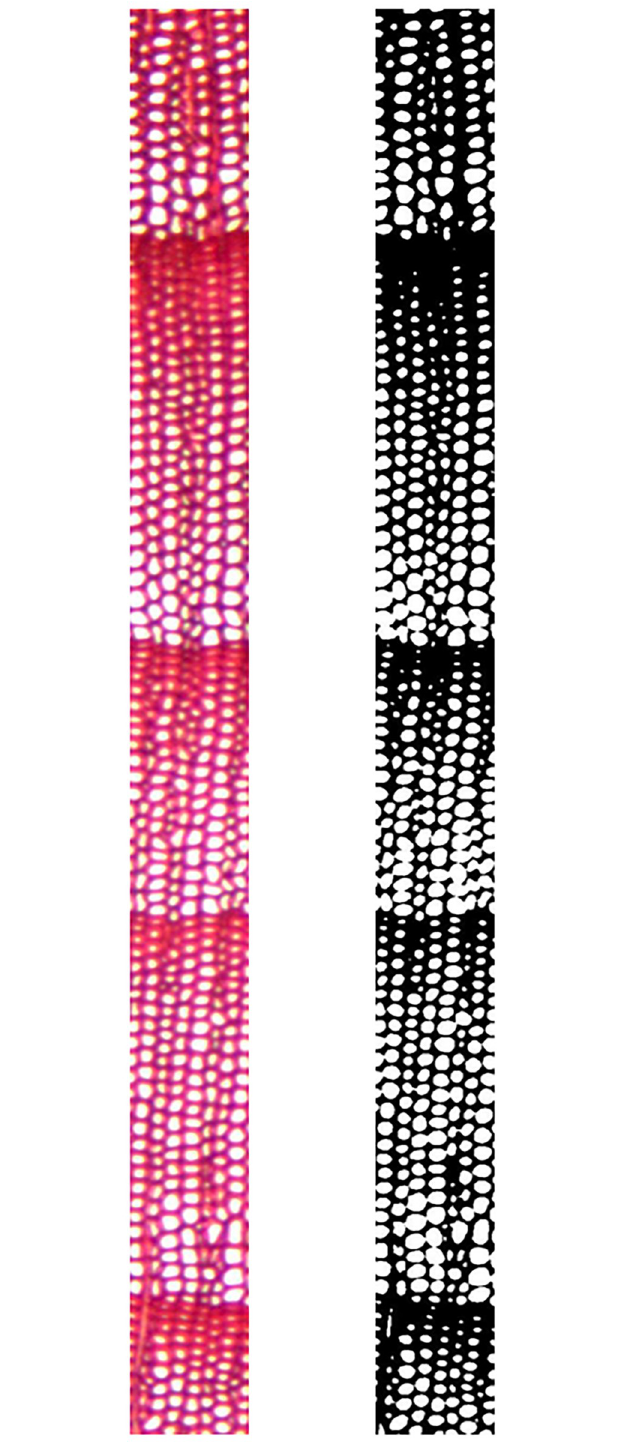
Fig 8. A comparison of sub-images before and after being binarized: -A: Original sub-image; -B: Binarization sub- image.